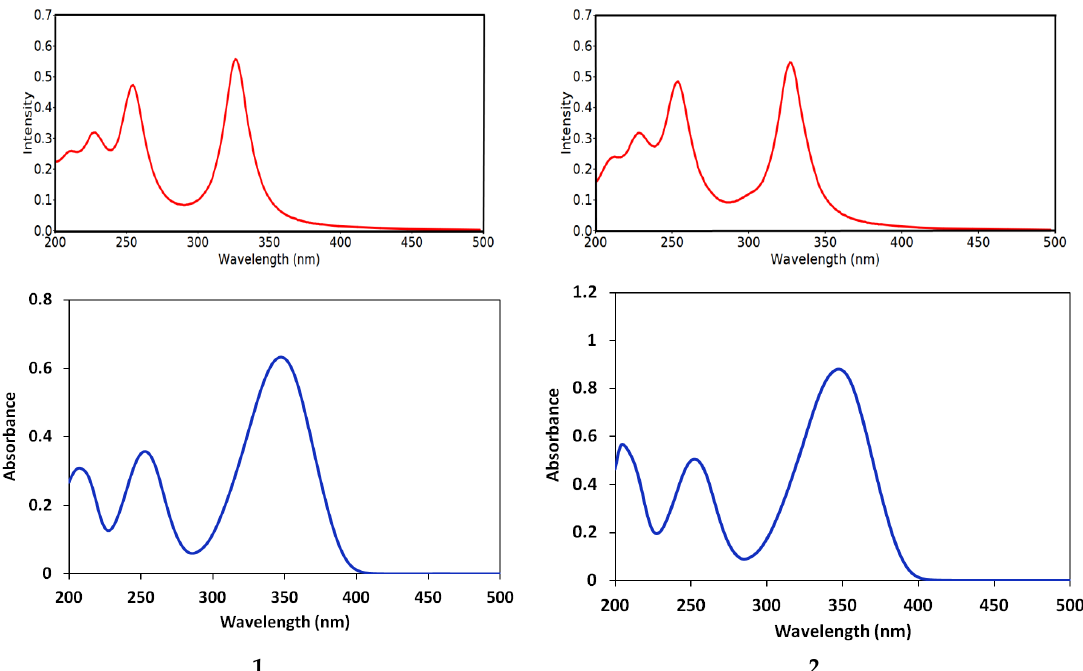
Figure 12. The experimental (blue) and calculated (red) UV-Vis electronic spectra of compounds 1 , and 2 .